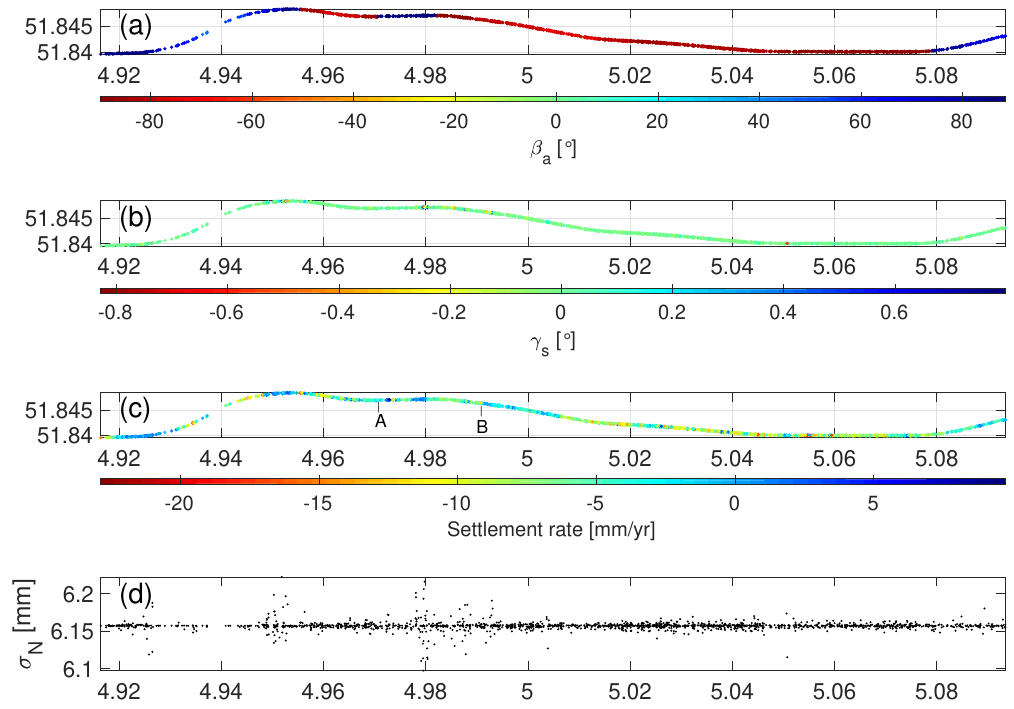
Figure 8. ( a ) The azimuth of track β a , ( b ) longitudinal slope γ s , ( c ) settlement rate in Normal direction, and ( d ) the standard deviation σ N in Normal when assuming σ LOS = 5 mm, along the